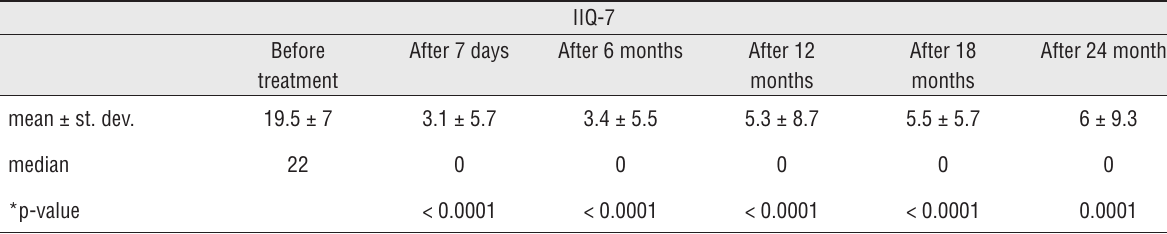
Table 5 - Quality of life (QoL) assessed by Incontinence Impact Questionnaire short form